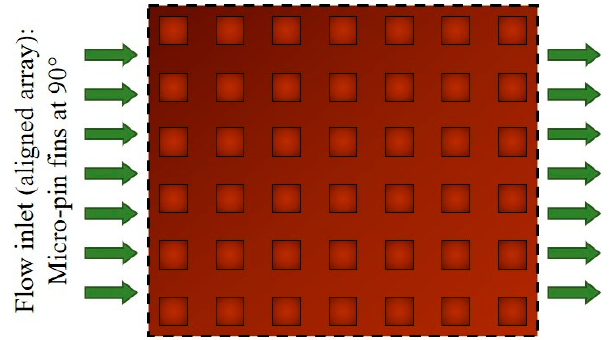
Figure 3. The constructive array of the micro pin fi ns.